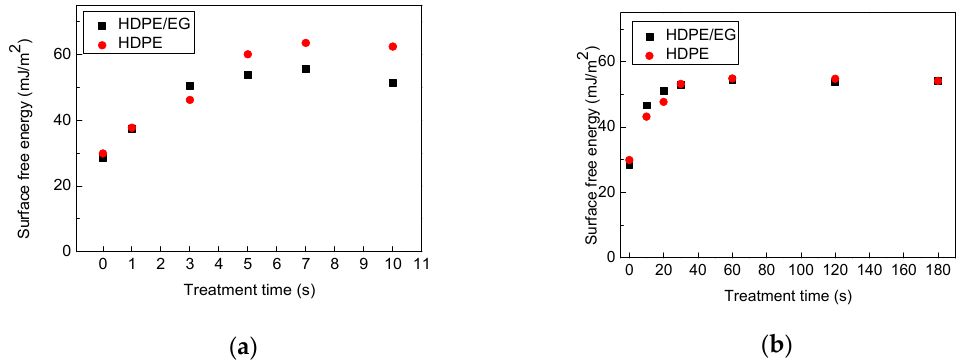
Figure 7. Effect of treatment time on the surface free energy of HDPE and HDPE/EG treated by ( a ) Figure 7. E ff ect of treatment time on the surface free energy of HDPE and HDPE / EG treated by corona and ( b ) RF plasma. ( a ) corona and ( b ) RF